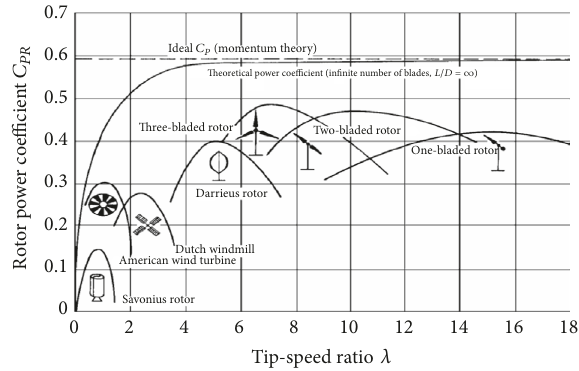
Figure 1: Typical performance of wind power machines.